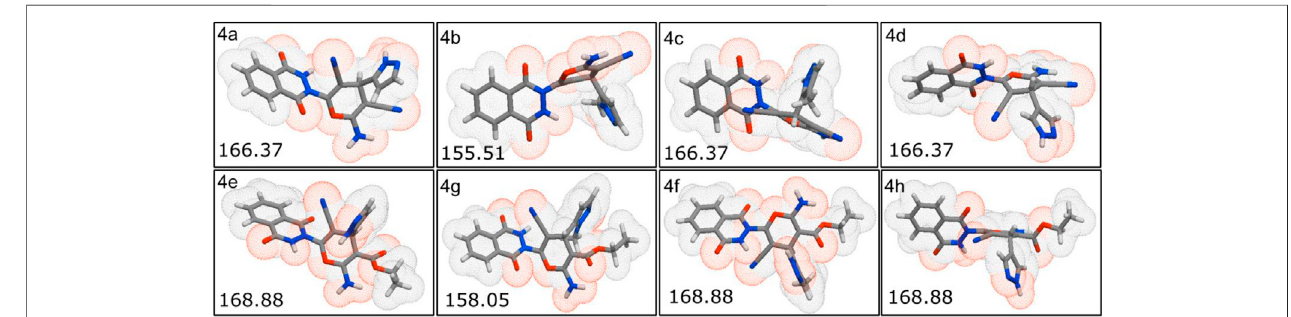
FIGURE 5 | Three-dimensional polar surface area visualization of all the synthesized molecules using Molinspiration tool.